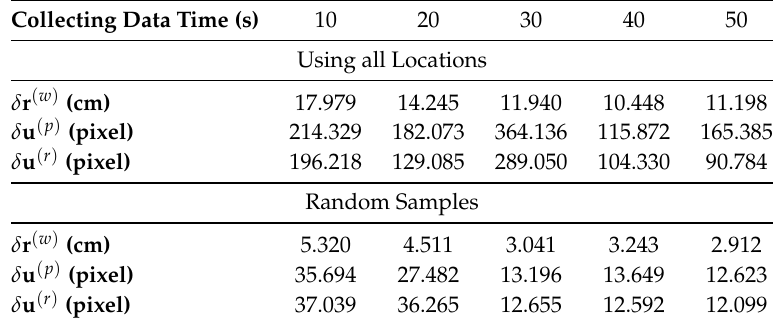
Figure 4. Example of detected the bottom and top positions of the pedestrians of Camera Network 2—single person doing household work in an kitchen room. Red color represents detected positions by the human pose estimation method. Green color represents the detected reprojected positions. Table 4. The calibration results on Camera Network 2 (CN2) within 1000 experiments of the proposed method. The table shows the results of our method on video sequence where the subject was cleaning the room. δ r ( w ) , δ u ( p ) , δ u ( r ) , and δ u ( rr ) denotes the triangulation error, projection error, reprojection error, and relative reprojection error,